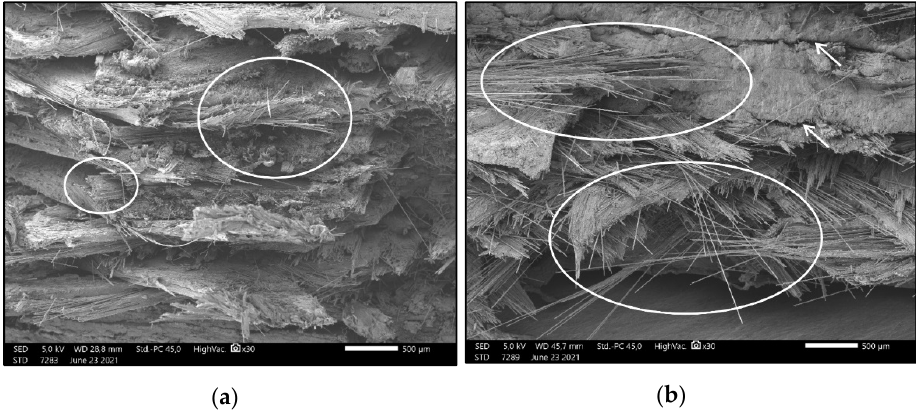
Figure 10. ( a ) Image demonstrating carbon fibers of nearly identical lengths (white circles); the layers are intact. ( b ) Image taken from the specimens used in the flexural fatigue test; the broken surface has cracks and hollows on it (white arrows), and the carbon fibers are elongated. The magnification was 30 × in both cases.